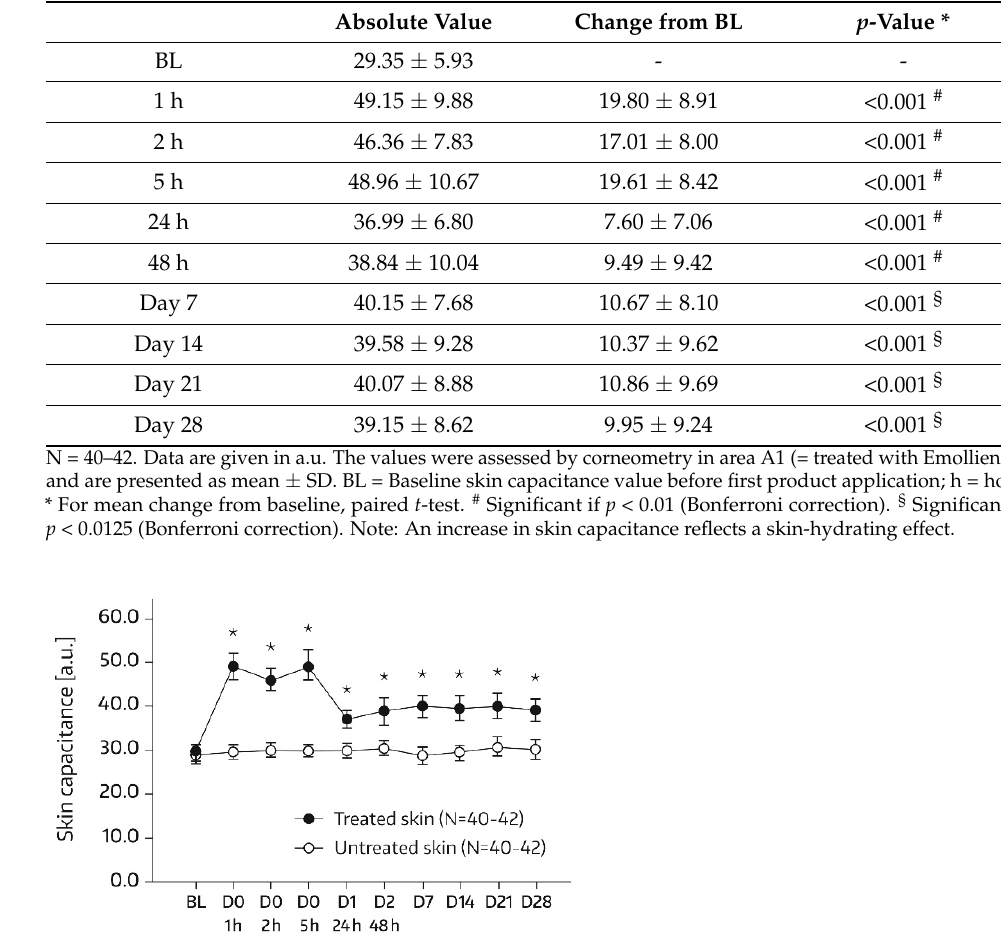
Figure 8. Results from skin capacitance measurements in untreated skin and skin undergoing a single application of Emollient 3 (first 48 h) followed by once-daily application for 26 days. The values were assessed by corneometry and are presented as mean ± SD. BL = Baseline skin capacitance value before first product application; D = day; h = hour. * p < 0.001 if compared to untreated control, paired t -test.